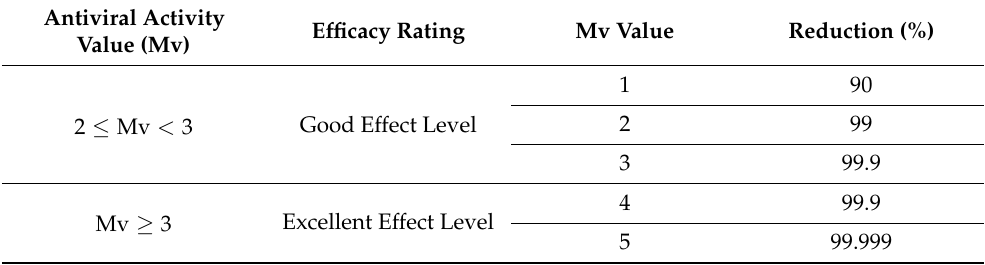
Table 3. Antiviral activity rating associated with percentage reduction of virus